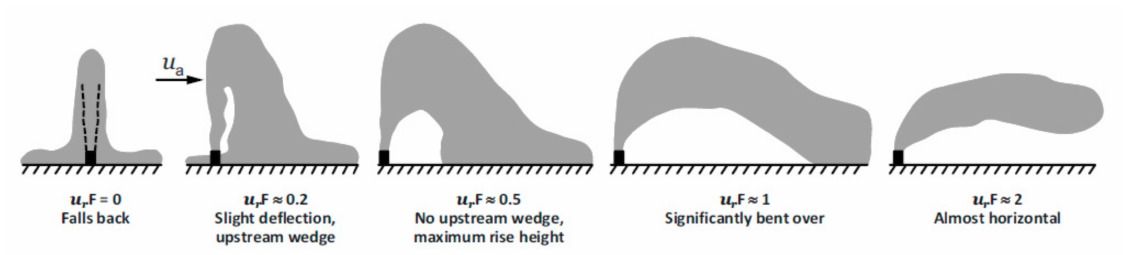
Figure 16. General flow characteristics for a vertical dense jet issuing into cross-flow with different values of u r F